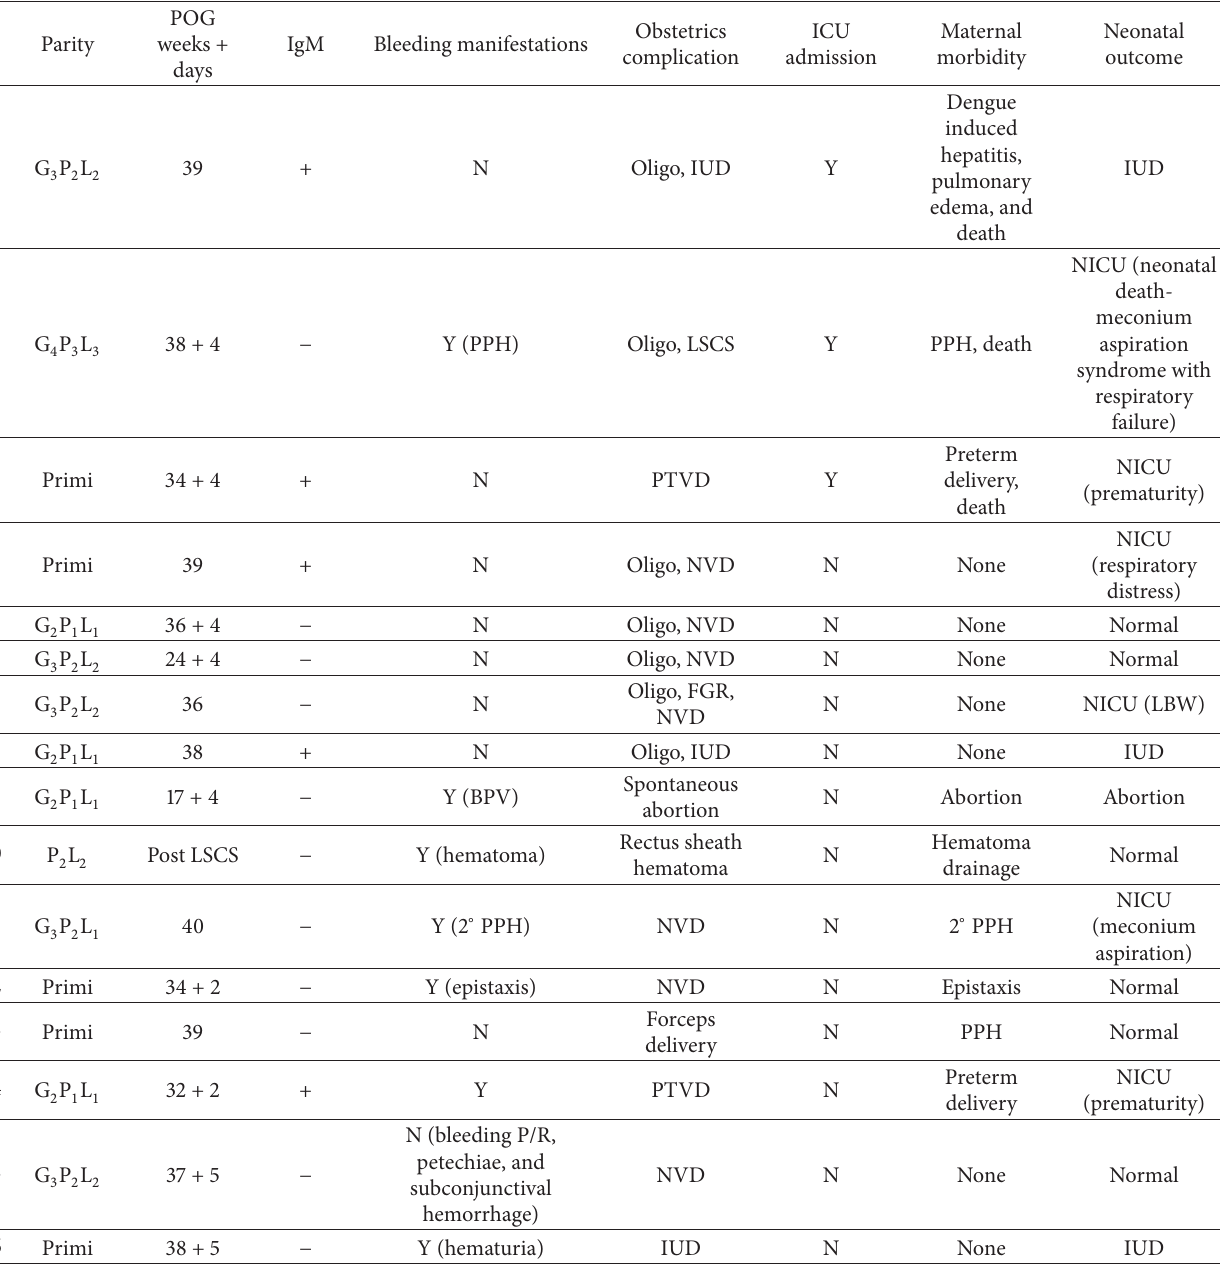
Table 1: Clinical profile of NS1Ag positive